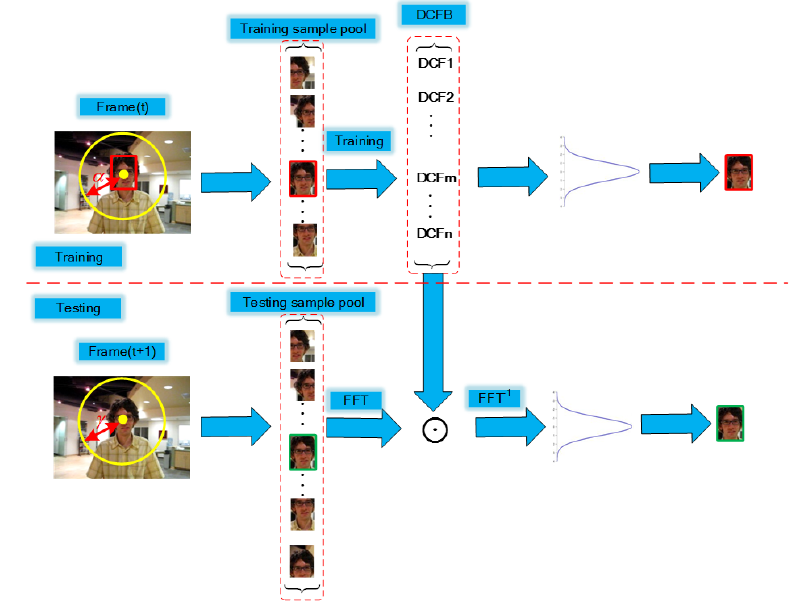
Figure 1. Overview of the proposed DCFB-based visual tracking algorithm. The operator (cid:74) is the Hadamard